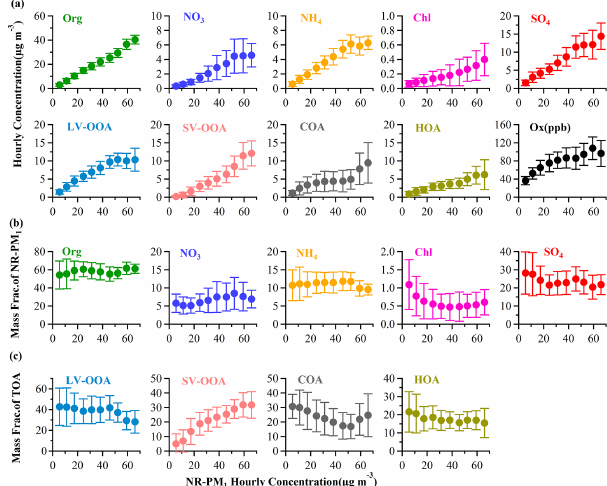
Figure 9. (a) Variations in mass concentration of NR-PM 1 species and OA components as a function of total NR-PM 1 mass loading, and (b) mass fraction of total NR-PM 1 for NR-PM 1 species as a function of total NR-PM 1 mass loading, and (c) mass fraction of total organics for OA components as a function of total NR-PM 1 mass loading. All the mass concentrations and fractions of above species were sorted according to the hourly average NR-PM 1 mass in ascending order. The solid circles represent the average value for each concentration bin with a width of 7µgm − 3 , and the vertical lines represent the standard